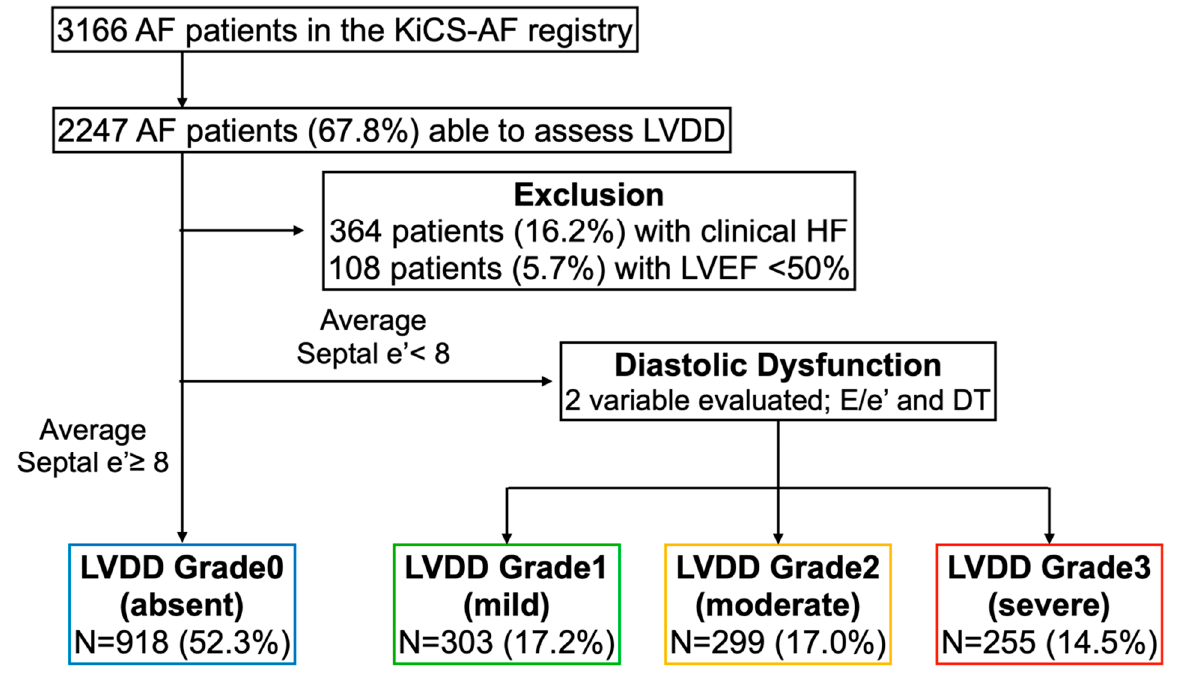
Figure 1. Study flow chart. Abbreviations; AF, atrial fibrillation; KiCS-AF, Keio Interhospital Cardio- vascular Studies-Atrial Fibrillation; LVDD, left ventricular diastolic dysfunction; LVEF, left ventricular ejection fraction, DT, deceleration time. Table 1. Baseline characteristics of the analytic